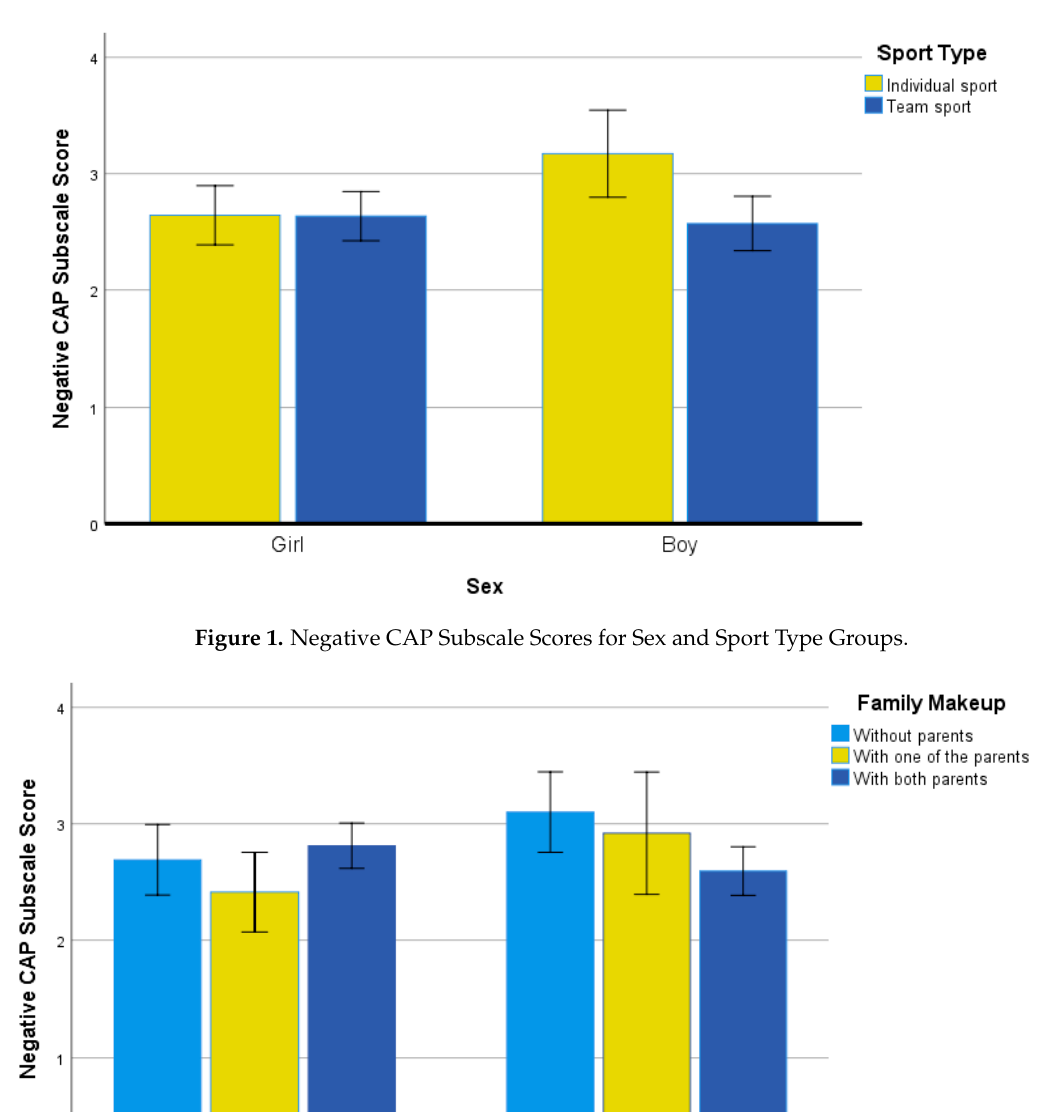
Figure 3. Negative CAP Subscale Scores for Sport Type and Family Makeup Groups. 4. Discussion This research aimed to understand whether the positive and negative processes in coach, athlete, and parent interpersonal relationships depended on number of athlete characteristics and sport type. Most of our interaction results, all with the negative PNP- CAP subscale, concerned family composition. It seems living without one’s parents, or with just one, impacts boys in individual sports more than girls in team or individual sports. The exact reason for this is unknown. Harwood and colleagues’ [29] study high- lighted that the motivational climate, for example, in a competition setting for an individ- ual sport athlete, remains largely understudied as well. Harwood et al. [29] also stated that such an understanding, through appropriate measurement, appears needed within individual sports, given that parents frequently interact with their child before, during, and after competition. This is an important contextual point about individual sports and the reliance on parental support [29].